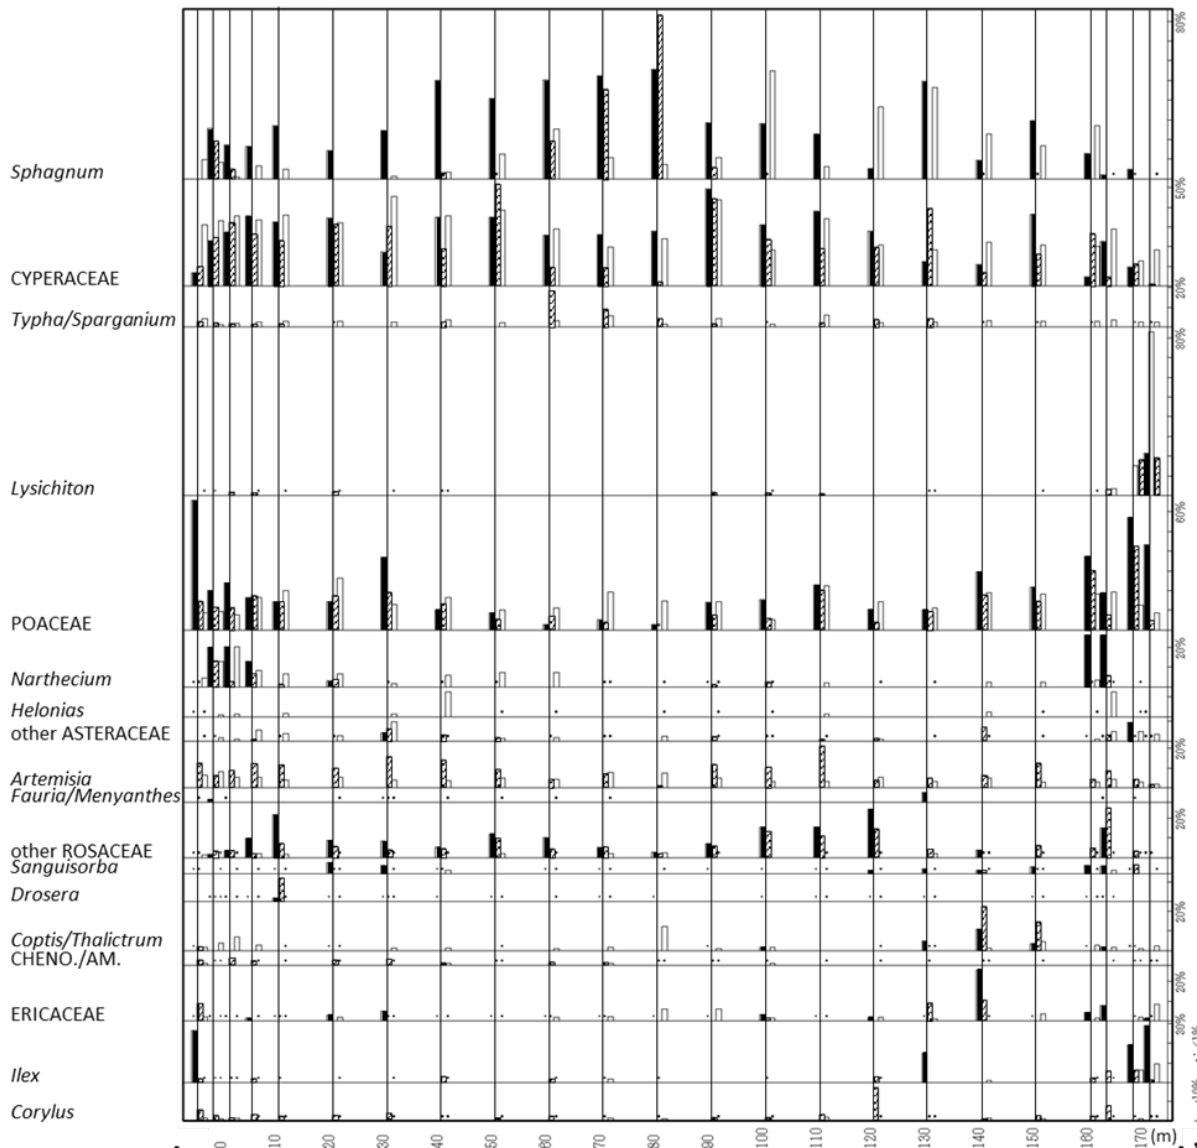
Figure 4. Diagram comparing percent coverage of plants (solid), surface pollen percentages (hatched) and pollen percentages in 915 CE (open) of selected non-trees on Line A. Pollen percentages are expressed as a proportion of the total non-tree pollen and spore count. Plus signs in the diagram indicate abundances < 1.0 %. CHENO./AM. stands for